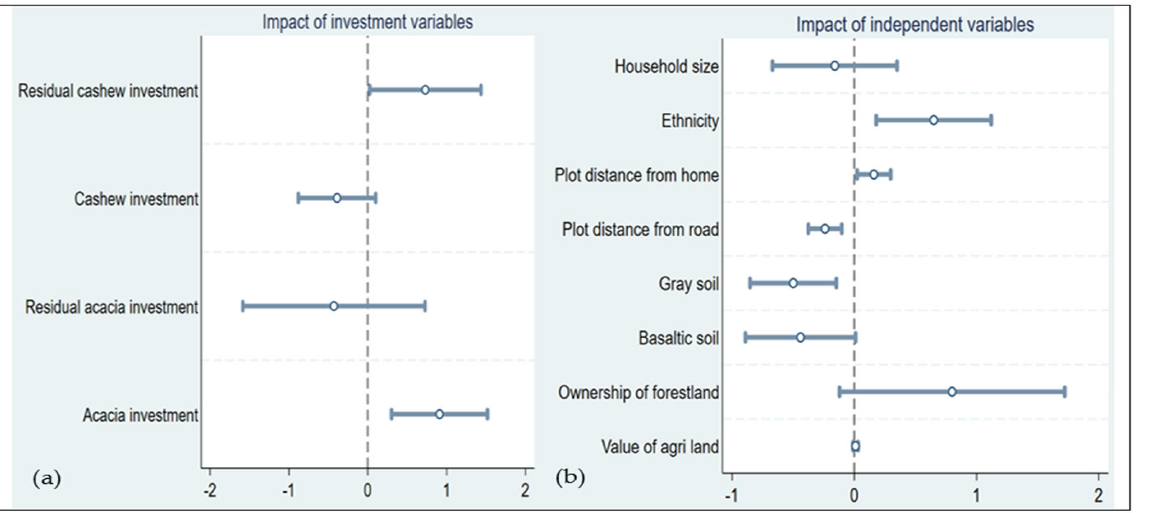
Figure 4. Causal impacts of tree investments on LTS perceptions ( a ) Effects of investment variables; ( b ) Effects of other independent variables (Bar length indicates parameter confidence interval).